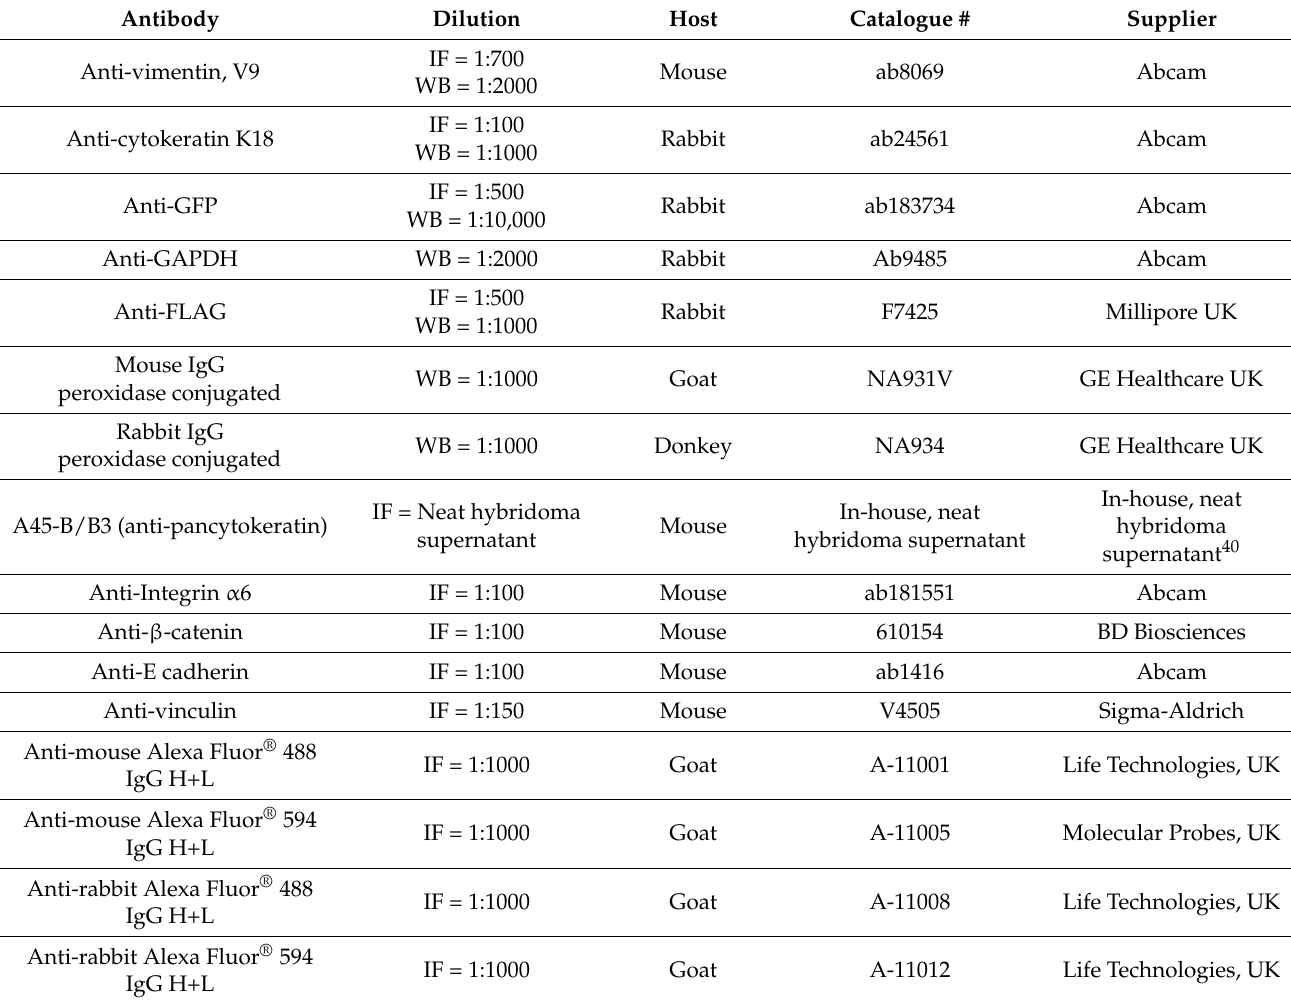
Table 2. List of primary and secondary antibodies used in this